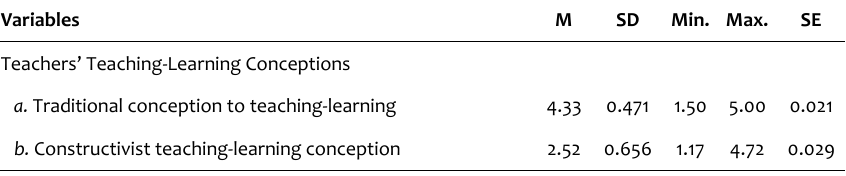
Table 1: Descriptive Statistics of Research